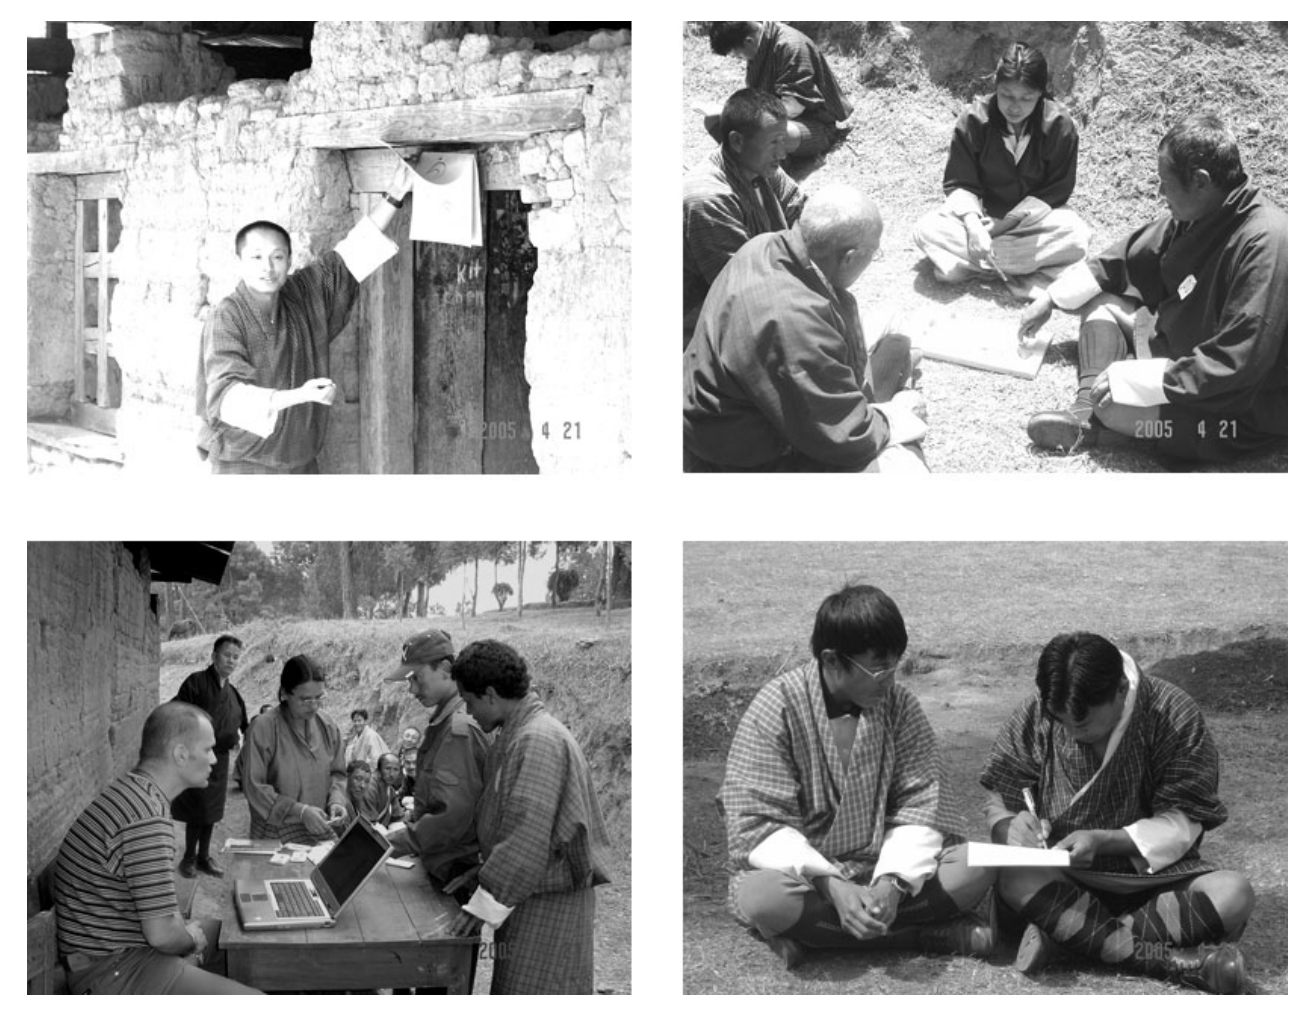
Fig. 7. Clockwise from upper left: declaring the weather and watershare, game in session, marketplace (settling accounts), and interview with player following the